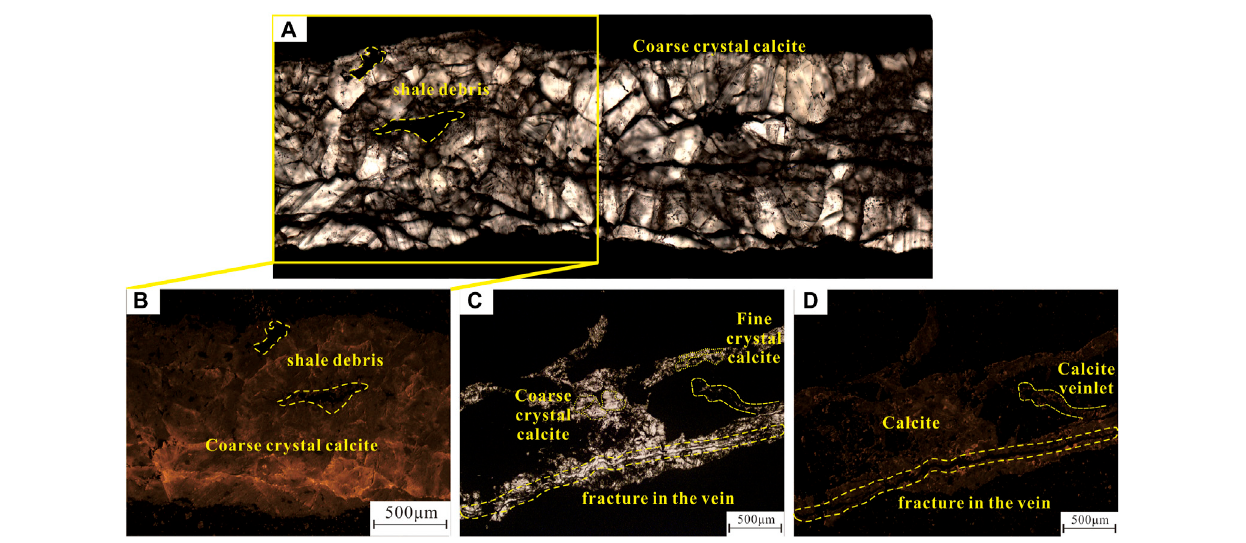
FIGURE 3 | Micrograph of calcite veins under (A) and (C) transmission light and (B) and (D) cathodoluminescence. (A) Coarse crystal calcite existed in veins of sample N228-3463.5 m, with shale debris mixed between calcites; (B) Calcites formed at different phases of fl uid evolution of sample N228-3463.5 m; (C) Fine crystal calciteinthedirectcontactpartbetweentheedgeoftheveinandthesurroundingrock,andcoarsecrystalcalcitetowardtheformationdirectioninsidetheveinofsample N228-3456.3 m, which fracture existed in, and calcite veinlets connected with the main vein existed in some surrounding rocks; (D) Calcite vein with dark-colored cathodoluminescence of sample N228-3456.3